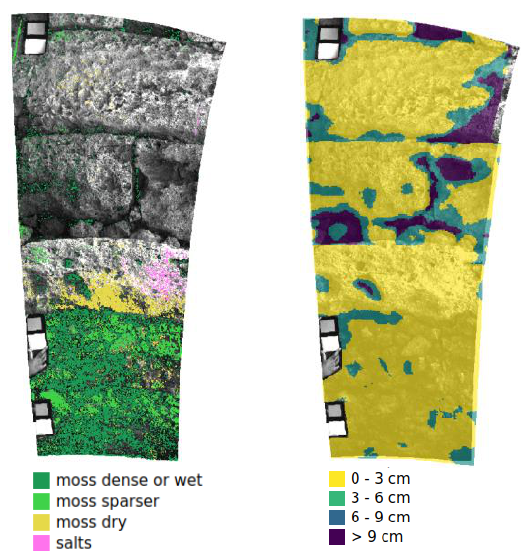
Figure 16. Left image: Biodeterioration map derived from MTMF spectral unmixing. Right image: Valley depth classes for the 3D model of the same wall (Roman